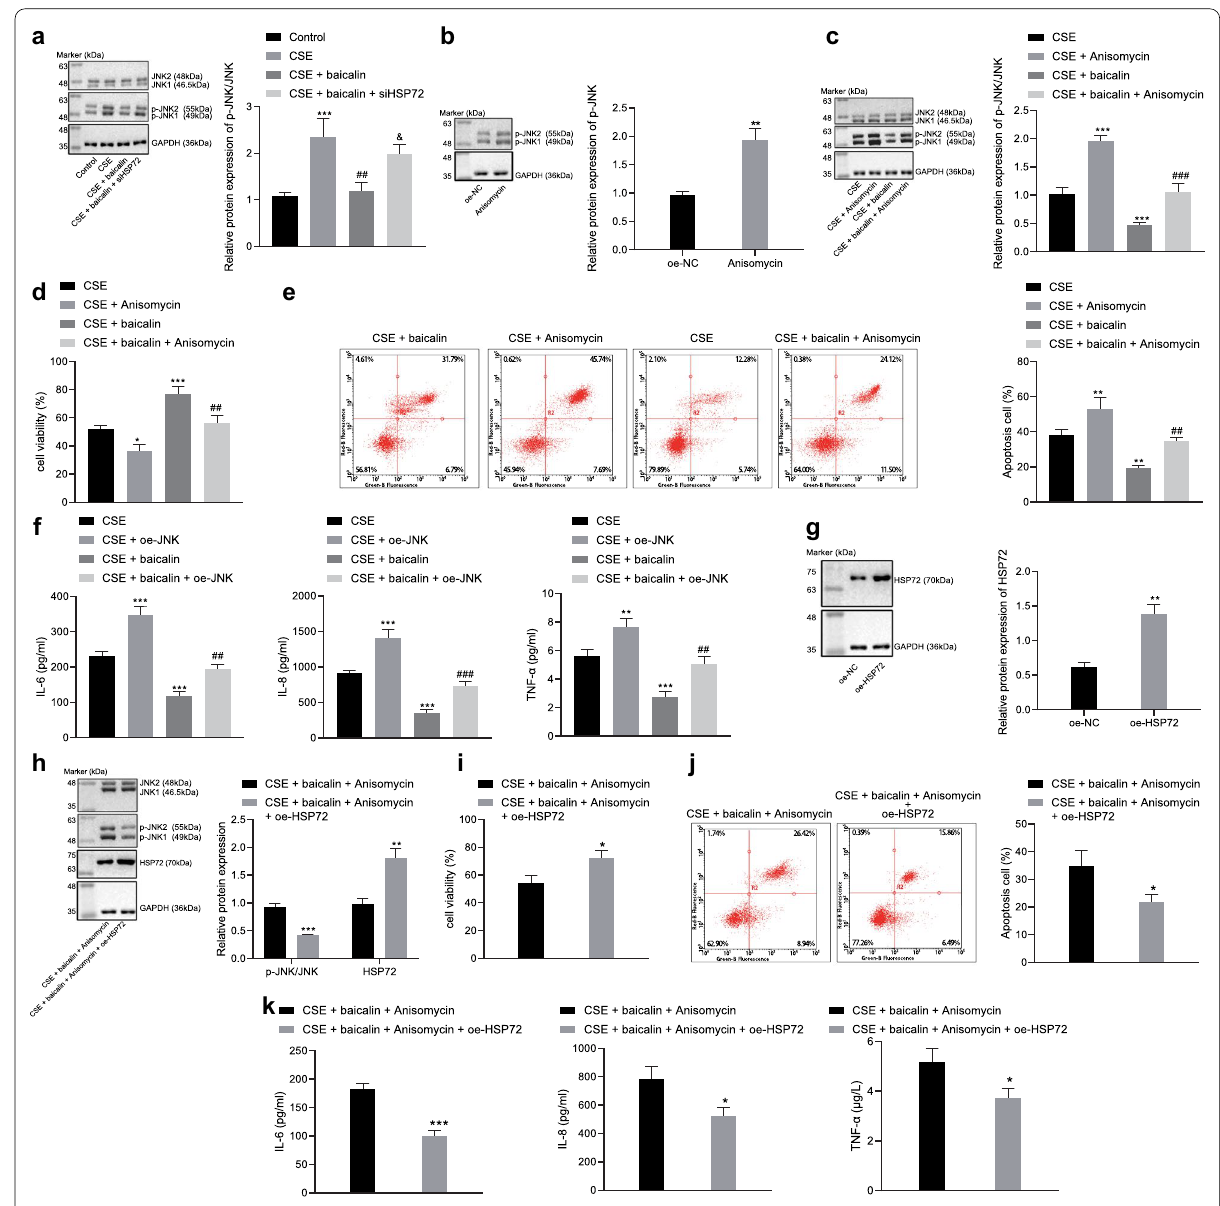
Fig. 6 Baicalin blocks the JNK signaling pathway and alleviates COPD in a HSP72 dependent manner. a MLE-12 cells were transfected with si-HSP72 or control vector and stimulated with CSE. The cells treated with baicalin and the phosphorylation of JNK normalized to GAPDH was analyzed by immunoblotting; * p < 0.05, ** p < 0.01, *** p < 0.001 compared to untreated cells; # p < 0.05, ## p < 0.01, ### p < 0.001 compared to cells treated with CSE; & p < 0.05, ## p < 0.01, ### p < 0.001 compared to cells treated with CSE baicalin. b The extent of JNK phosphorylation after Anisomycin treatment + normalized to GAPDH was tested by immunoblotting. * p < 0.05, ** p < 0.01, *** p < 0.001 compared to cells treated with vehicle. c The phosphorylation of JNK normalized to GAPDH was analyzed by immunoblotting. d Cell viability was analyzed by CCK-8. e Cell apoptosis was analyzed by flow cytometry. f Release of IL-6, IL-8 and TNF-α was analyzed ELISA. * p < 0.05, ** p < 0.01, *** p < 0.001 compared to cells treated with CSE; # p < 0.05, ## p < 0.01, ### p < 0.001 compared to cells treated with CSE baicalin. g Relative protein expression of HSP72 normalized to GAPDH after treatment of HSP72 + overexpression vector was determined by immunoblotting. * p < 0.05, ** p < 0.01, *** p < 0.001 compared to cells transfected with oe-NC. h Cells were co-transfected with both Anisomycin and oe-HSP72 and stimulated with CSE. The expression of HSP72 and extent of JNK phosphorylation normalized to GAPDH was analyzed by immunoblotting. i Cell viability of both JNK-activated and HSP72-overexpressed cells after treatment with baicalin was analyzed by CCK-8 assay. j Cell apoptosis of both JNK-activated and HSP72-overexpressed cells after treatment with baicalin was analyzed by flow cytometry. k Release of IL-6, IL-8 and TNF-α of both JNK-activated and HSP72-overexpressed cells after treatment with baicalin was analyzed ELISA. * p < 0.05, ** p < 0.01, *** p < 0.001 compared to cells treated with CSE baicalin Anisomycin. All experiments were repeated for three + + times independently and the data were represented as mean standard deviation. One-way ANOVA followed by Tukey’s test was used for multiple ± group